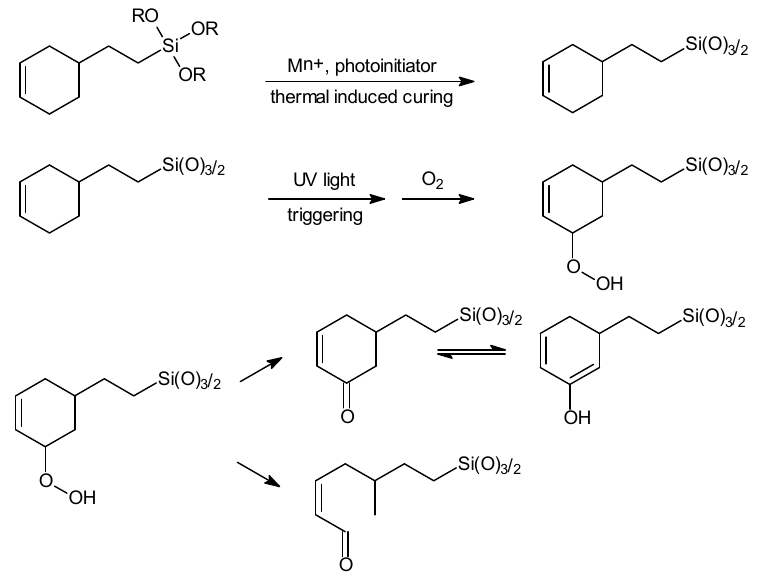
Figure 2. Proposed mechanism of the transition metal-catalyzed oxidation of the silylated cyclic olefin compound [Fraunhofer ISC].